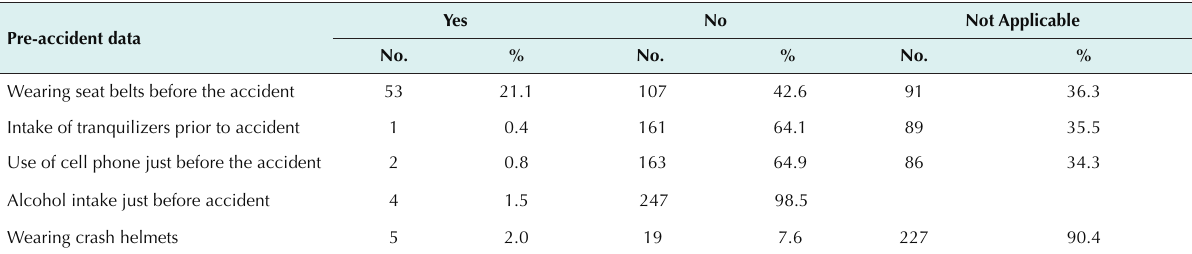
Table 5. Distribution of RTA Victims According to Some Pre-accident Related Factors Pre-accident data